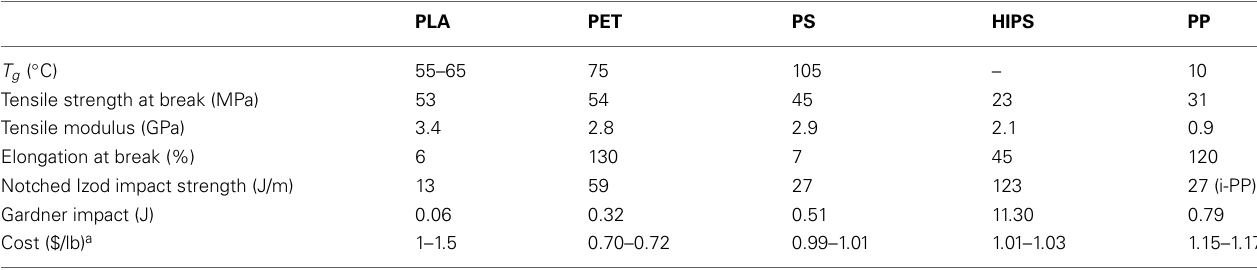
Table 1 | PLA mechanical properties compared to those of most common polymers used in commodity applications [Copyright ©(2011) Wiley and Sons; used with permission from Liu and Zhang